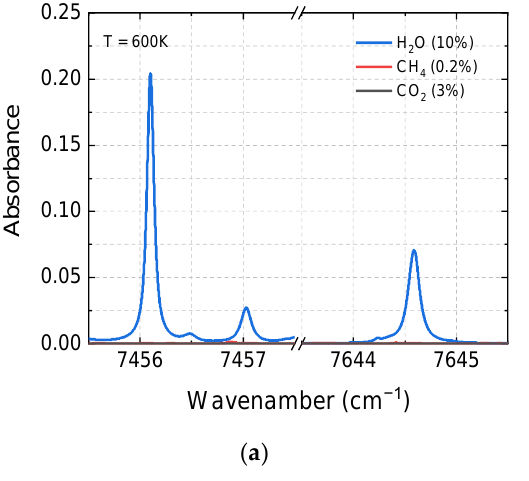
Figure 2. Absorbance simulation of three candidate H 2 O transitions ( a ) and the corresponding line strength varying from 300 to 900 K ( b ). P = 1 atm, L = 2 m, T = 600 K, X H2O = 10%, X CH4 = 0.2%, X CO2 = 3%.